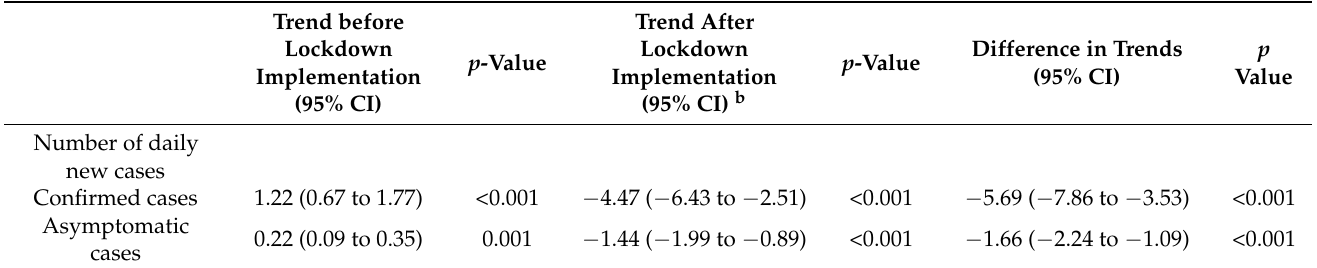
Table 1. Changes in daily new confirmed cases and asymptomatic cases after lockdown was imple- mented in Shenzhen a